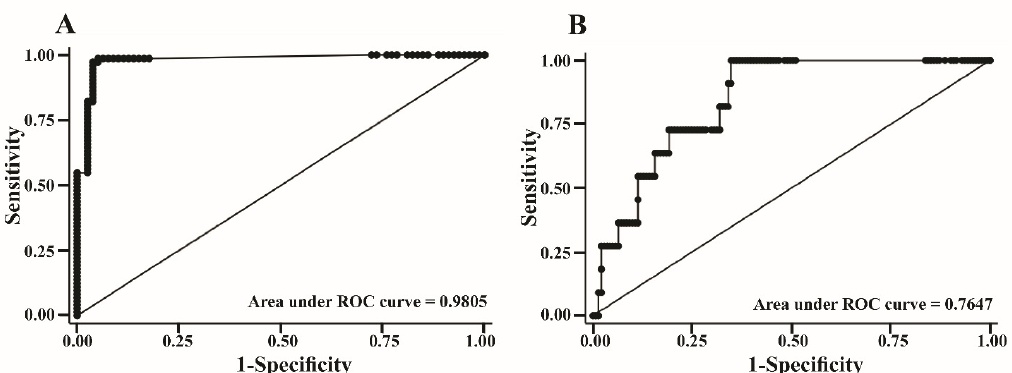
Figure 6. The ROC curve analysis was performed on the expression of COL5A2 , ezrin , and VIM to